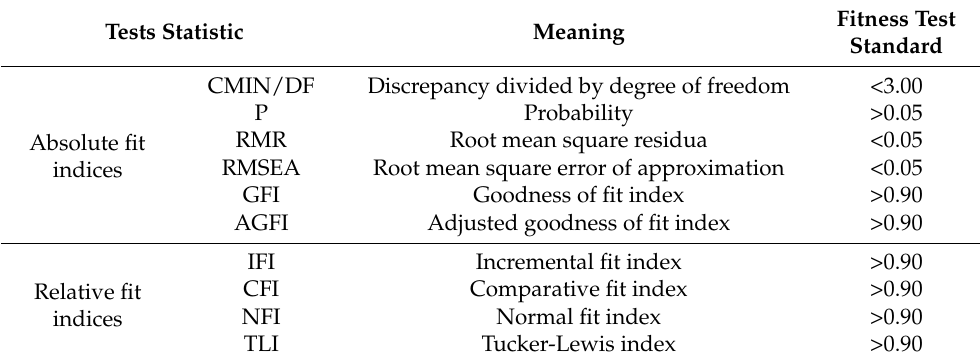
Table 5. Fitness test standards of the